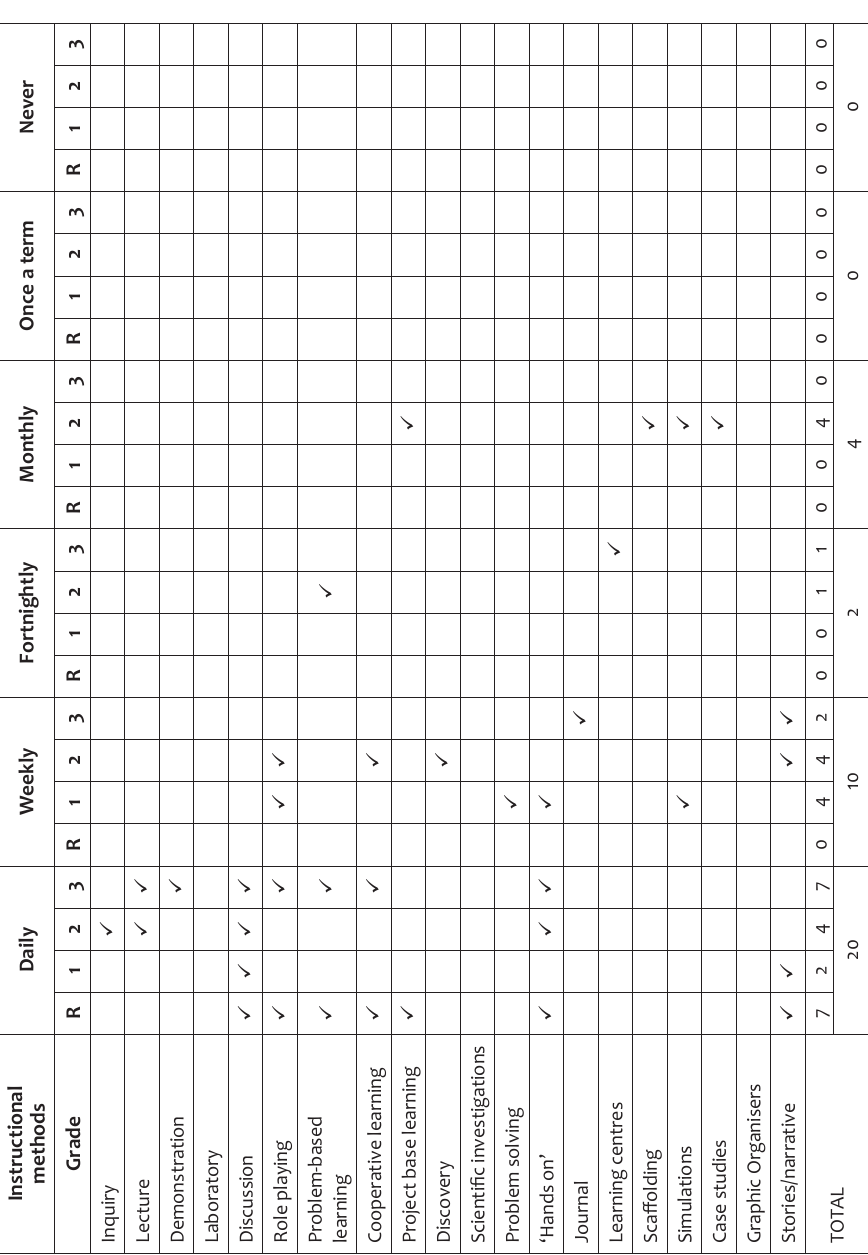
Table 2: Frequency of instructional methods used by each